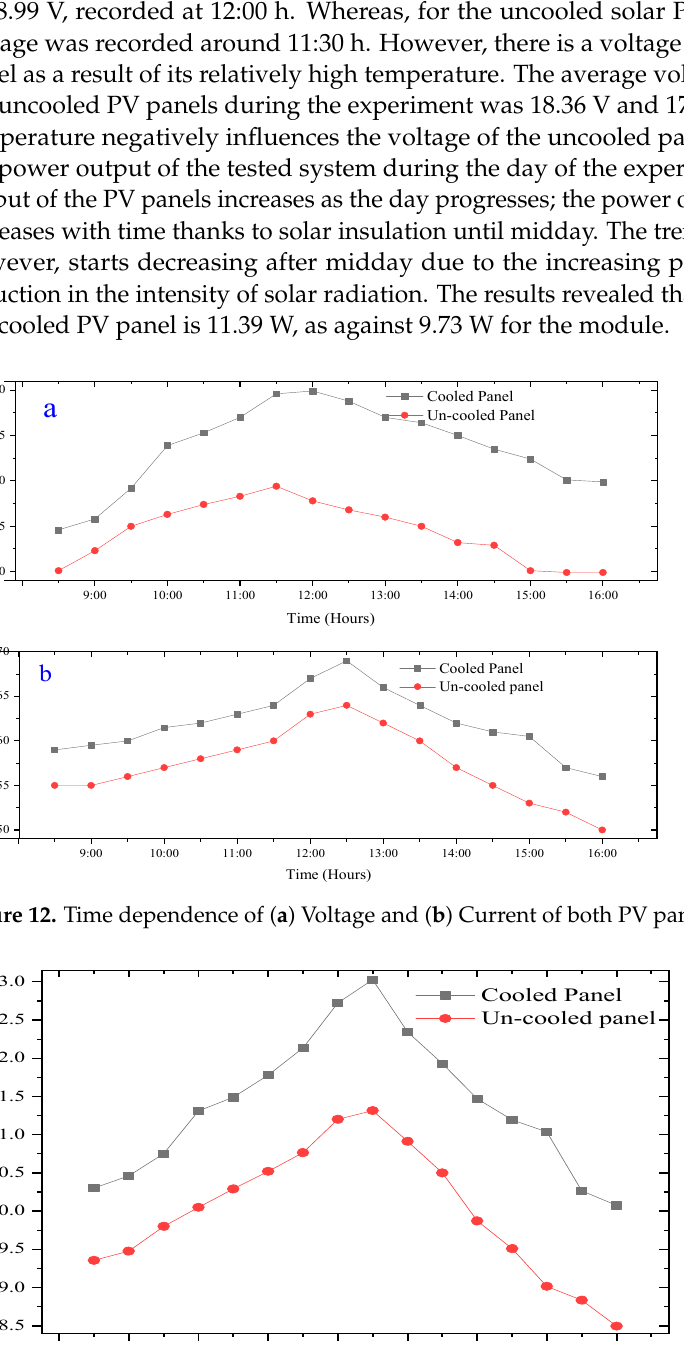
Figure 11. Thermal image of an uncooled PV panel.